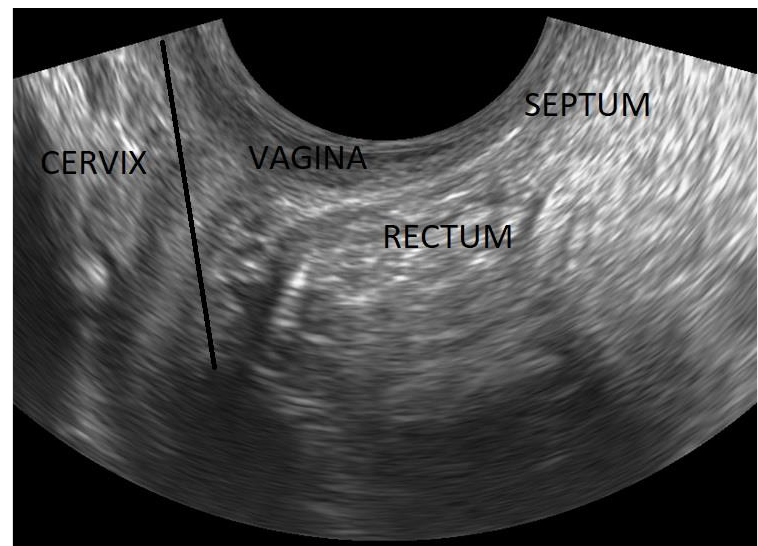
Figure 10. The normal rectovaginal septum as a thin white line between the posterior vaginal wall and the anterior rectal wall. The black line (which passes just below the inferior limit of the cervix) demarcates the upper limit of the rectovaginal septum.